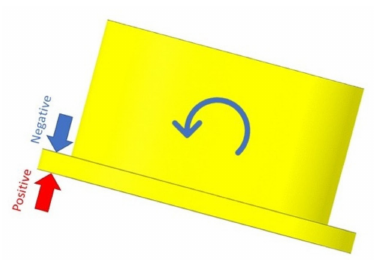
Figure 10. Signal of the different pressure adopted: positive, upward force direction, negative, downforce direction.